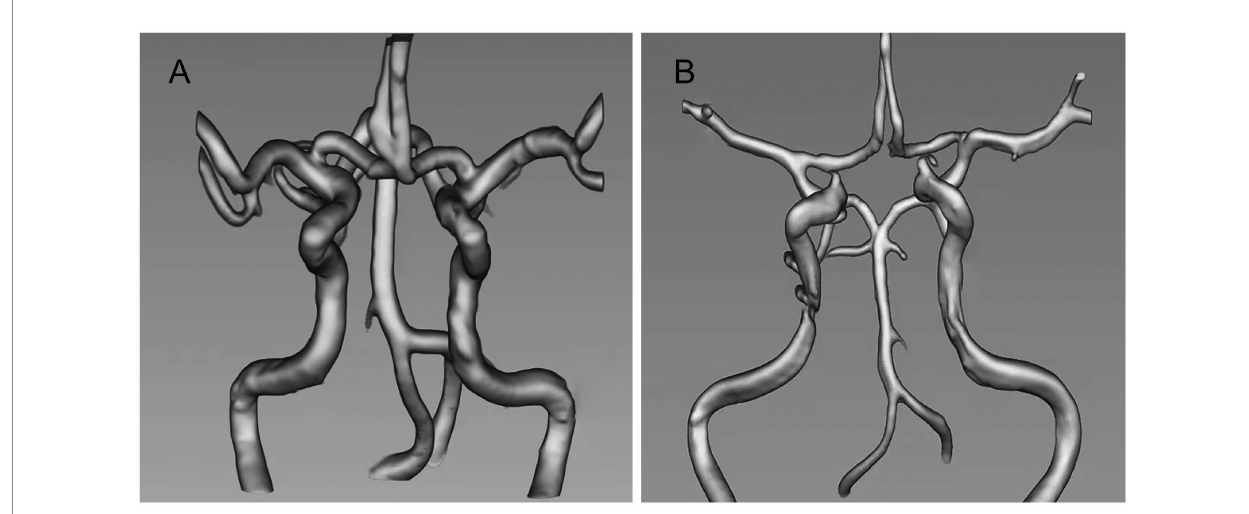
FIGURE 2 (A) Positive intracranial arterial remodelling. (B) Non-positive intracranial arterial